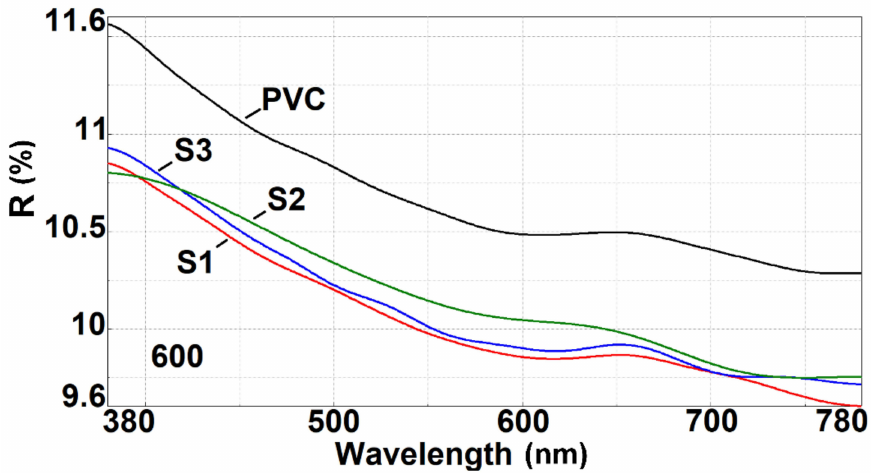
Figure 3. Diffuse reflectance spectra of the PVC substrates: uncoated and coated with silica materials (TEOS/MTES/OTES (S1), TEOS/MTES/VTMES (S2) and TEOS/MTES/HDTMES